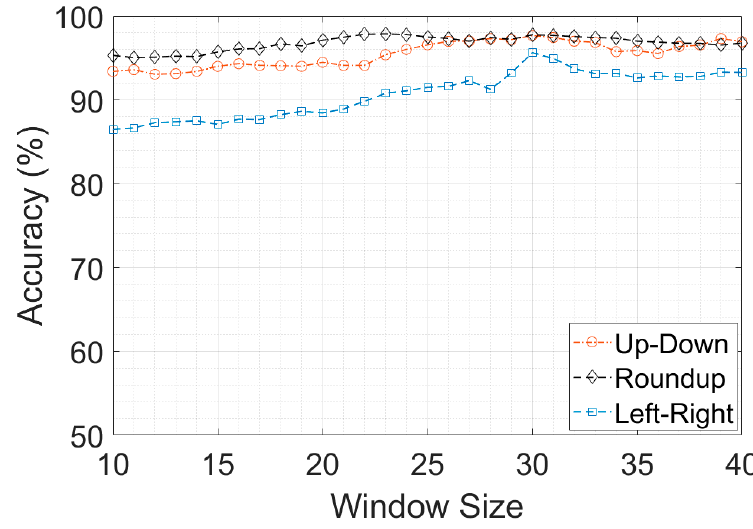
Figure 15. Three kinds of finger motion: ( a ) up ‐ down, ( b ) left ‐ right, and ( c ) round ‐ up.